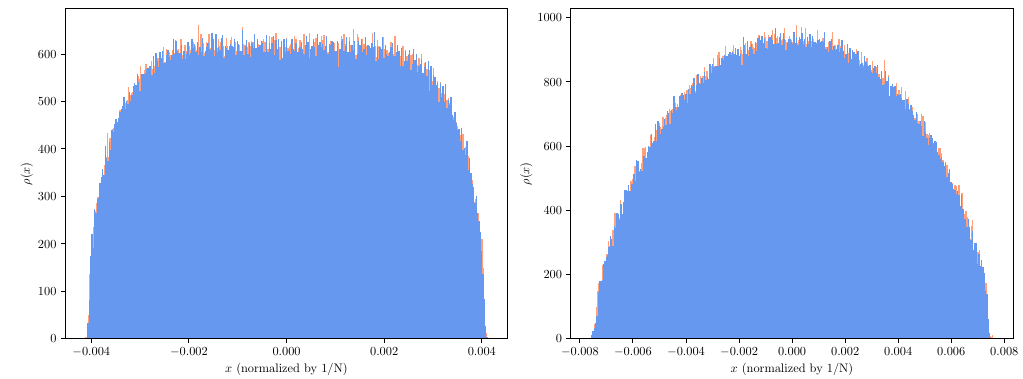
Figure 8: Left: The eigenvalue distribution of two matrices for g = h = 1 with N = 300. Right: The parabolic distribution for g = 0, h = − 0.04965775 with N = 300.